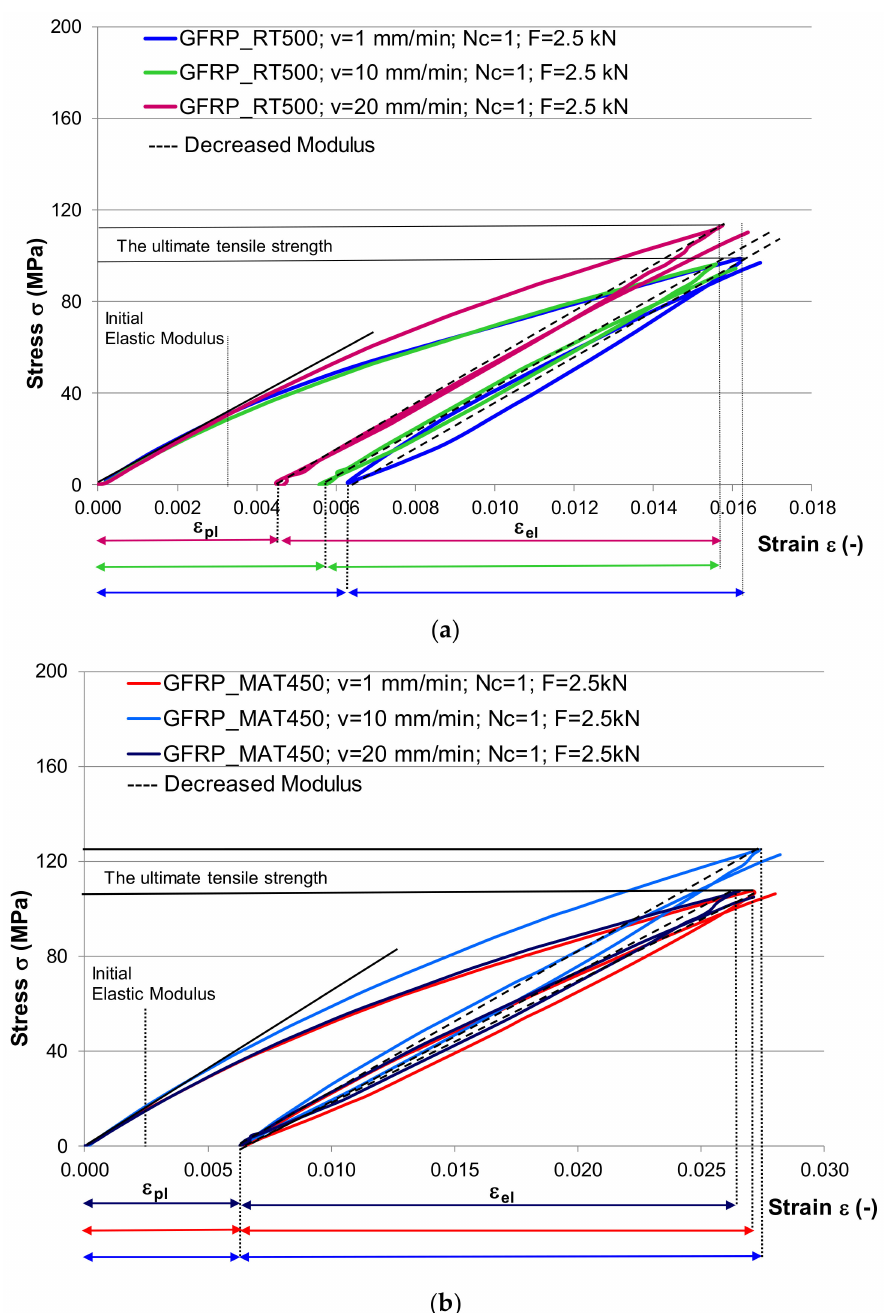
Figure 5. The stiffness loss in fibers direction during first cycle, for different speed loading: ( a ) GFRP-RT500 samples; ( b ) GFRPMAT450 samples (legend: v—speed loading; Nc—number of loading cycles; F—the maximum applied loading; ε pl —plastic strain; ε el —elastic